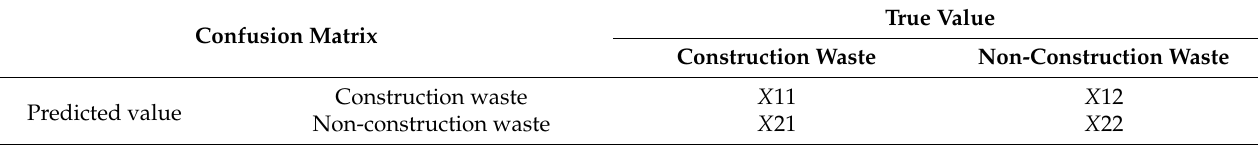
Table 1. The graph of the confusion